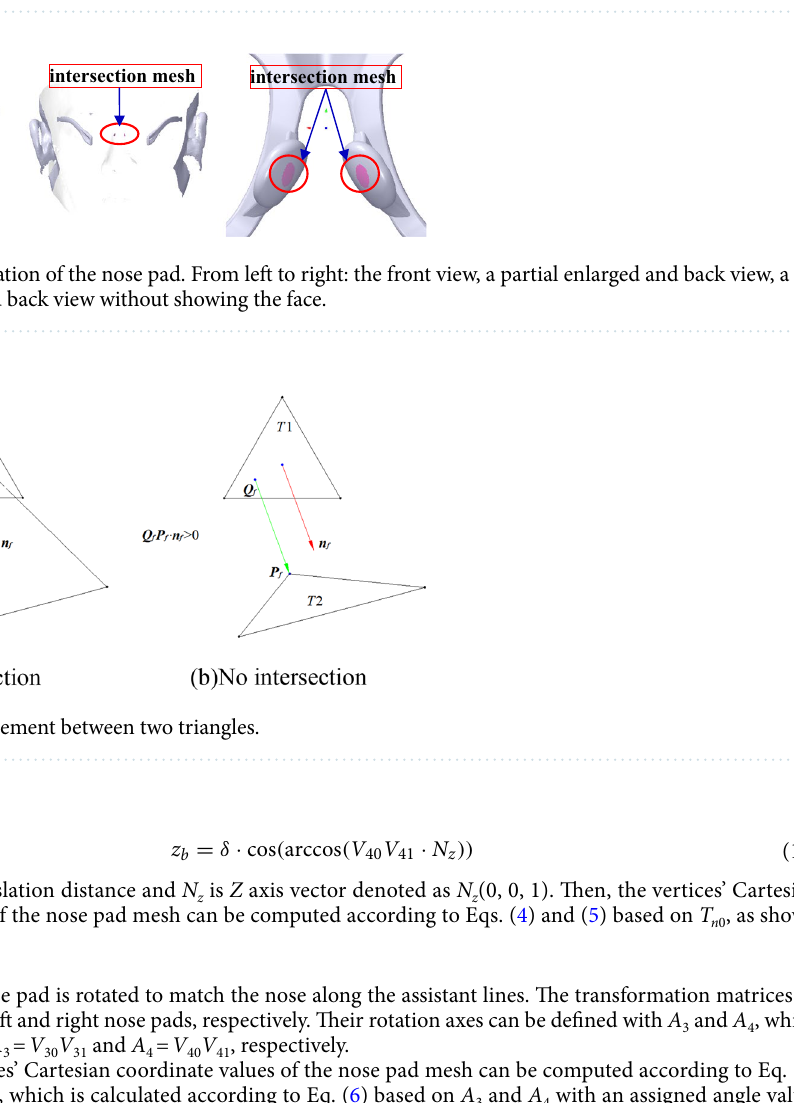
Figure 18. The translation of the nose pad. From left to right: original nose pad, the translation of the nose pad, the translation of the nose pad with a partially enlarged view, and the translation of the nose pad with a partially enlarged view without showing the face.